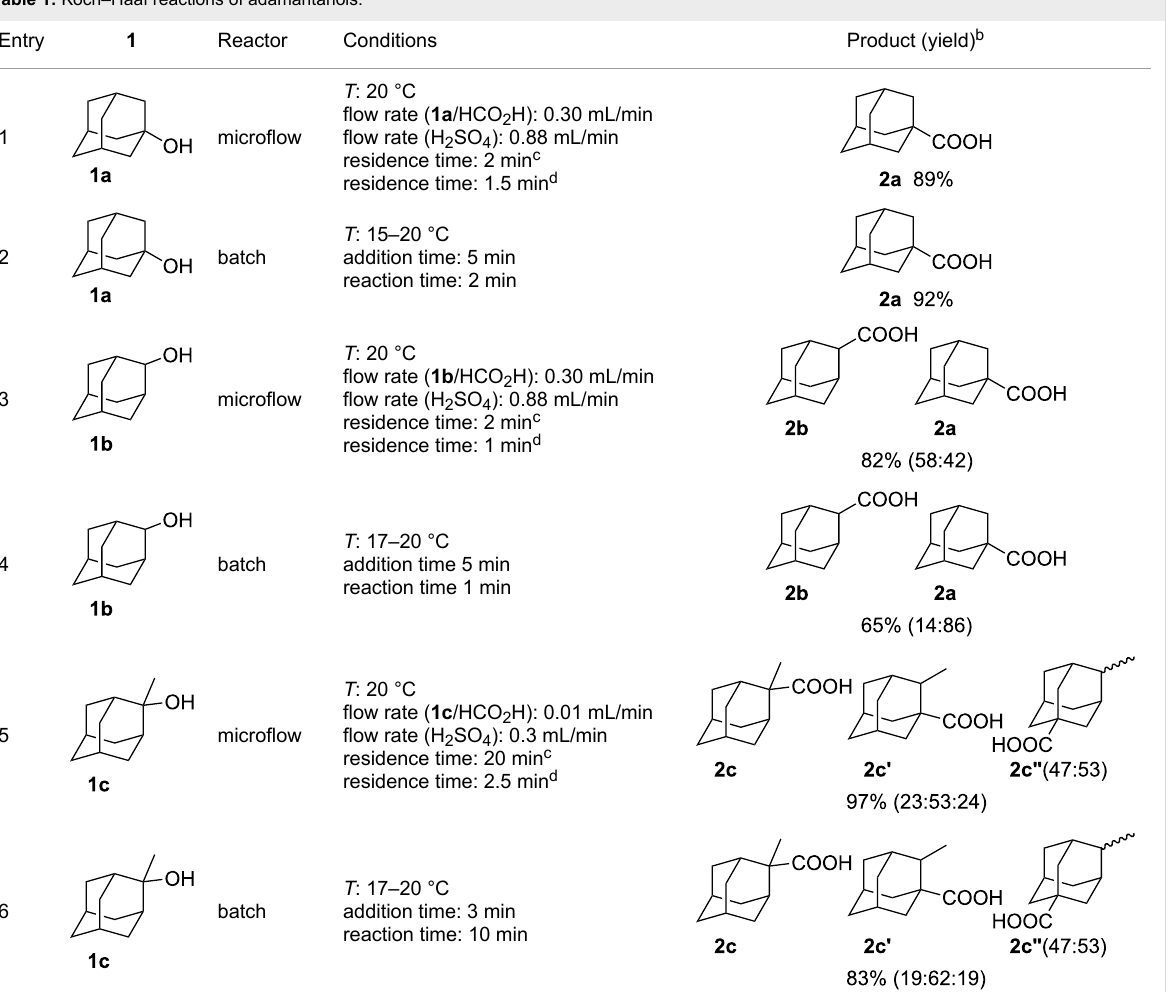
Table 1: Koch–Haaf reactions of adamantanols.